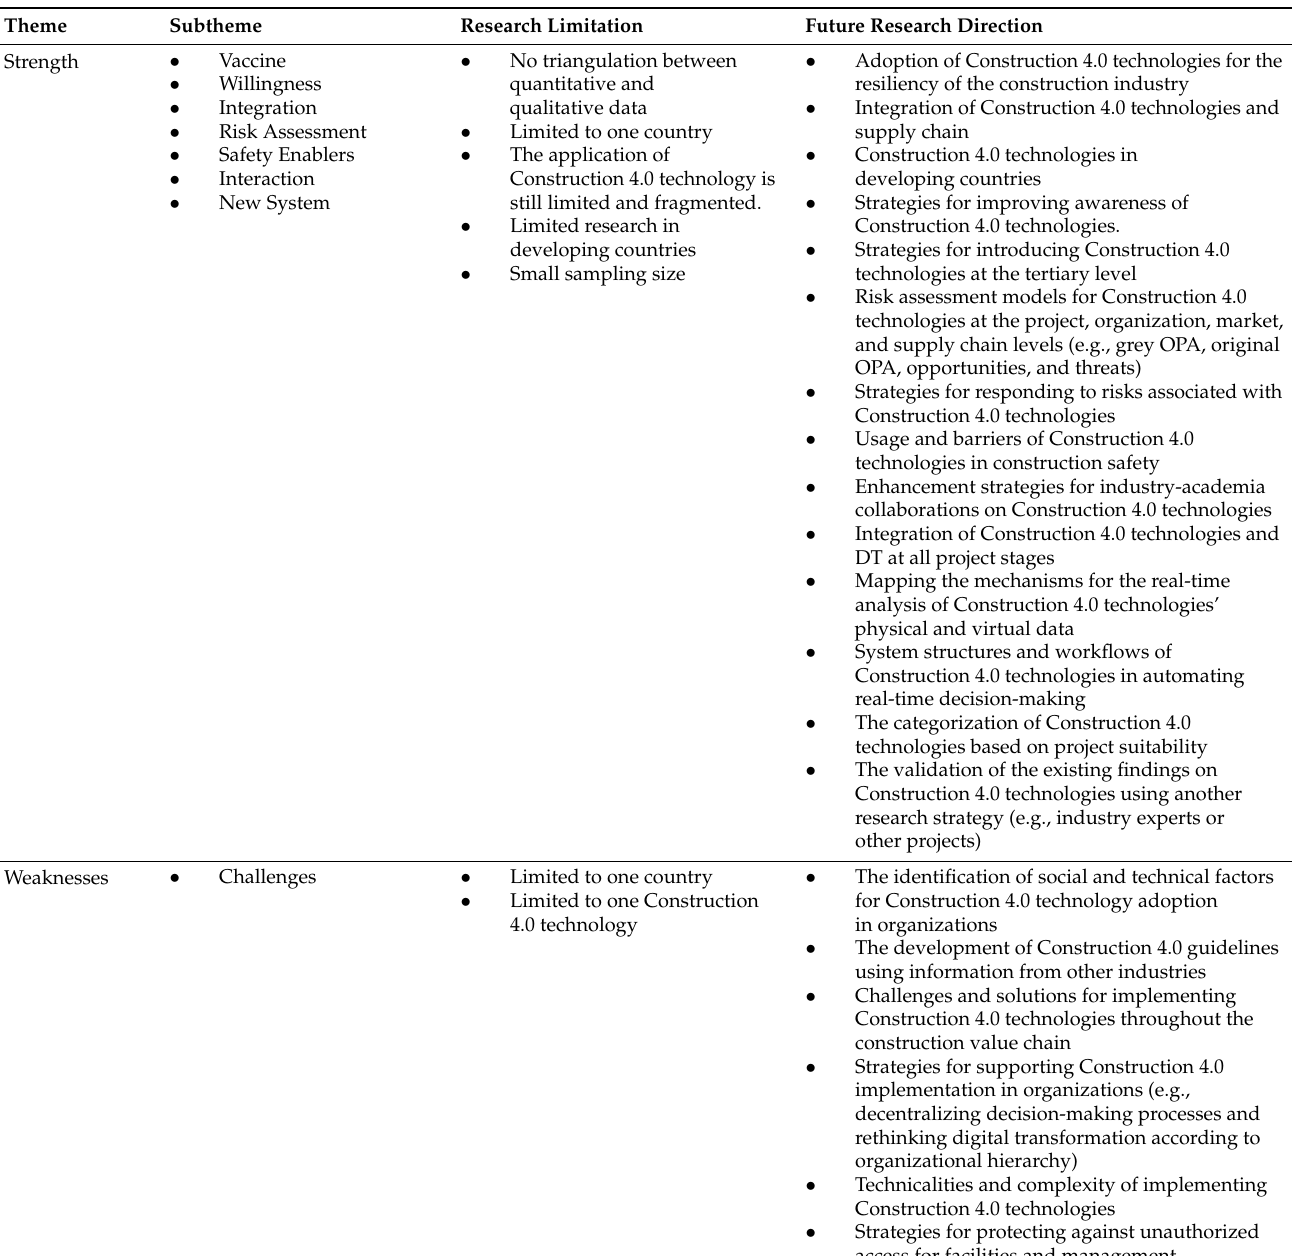
Table 3. The link between the existing research, research limitations, and future research